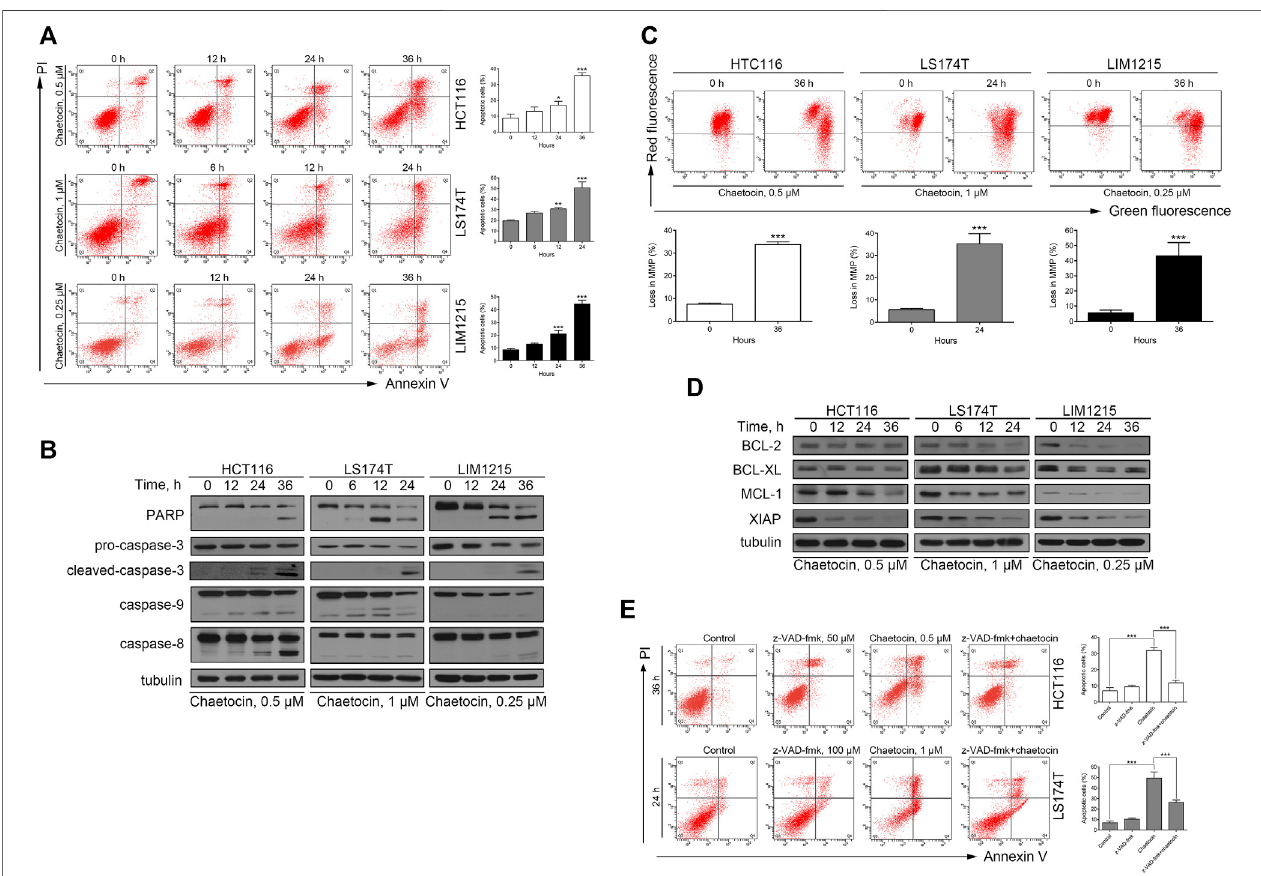
FIGURE2 | Chaetocin induces caspase-dependent apoptosis in CRC cells. (A) Flow cytometry results with Annexin V-FITC/PI stainingon apoptotic population of HCT116, LS174T and LIM1215 after chaetocin treatment. (B) Western blot analysis of PARP, caspase-3, capase-9 and caspase-8 expression levels in HCT116, LS174TandLIM1215cells. (C) FlowcytometryresultswithJC-1stainingonthreeCRCcelllines. (D) WesternblotresultstoevaluatetheproteinlevelofBCL-2,BCL-XL, MCL-1 and XIAPinCRCcell lines. (E) A2 h z-VAD-fmk pretreatmentcouldrescue someHCT116 and LS174Tcellsfrom apoptosis inducedbychaetocin. For (A) , (C) and (E) ,resultswereshownasmean ± SDofthreeindependentexperiments.* p < 0.05,** p < 0.01,*** p < 0.001.For (A) and (C) ,comparisonwasagainst0 hgroup.